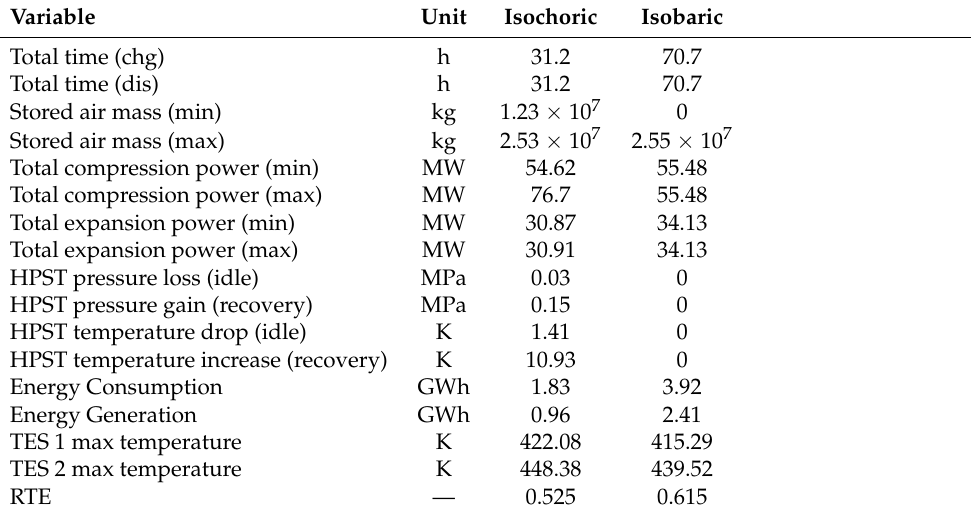
Table 2. Simulation results for the isobaric and isochoric case in which ∆ η = 0.35. Variable